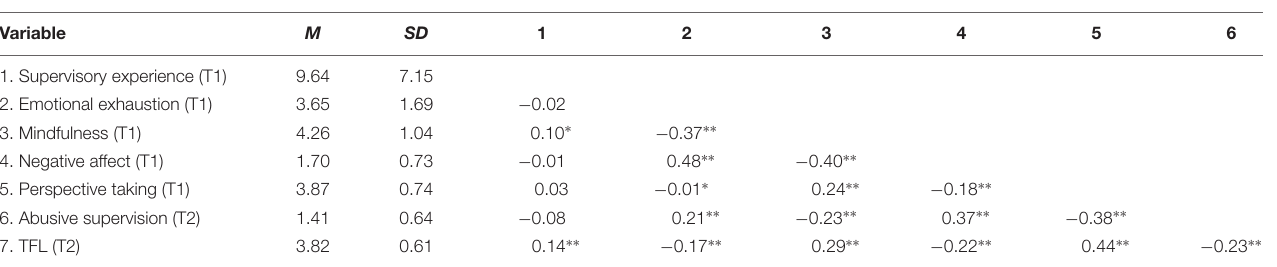
TABLE 1 | Means, standard deviations, and intercorrelations among variables.